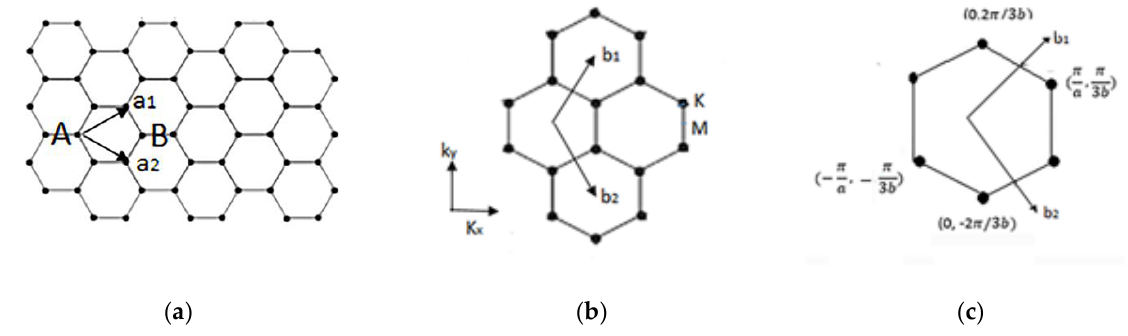
→ → b 1 , b 2 basis vectors; ( c )